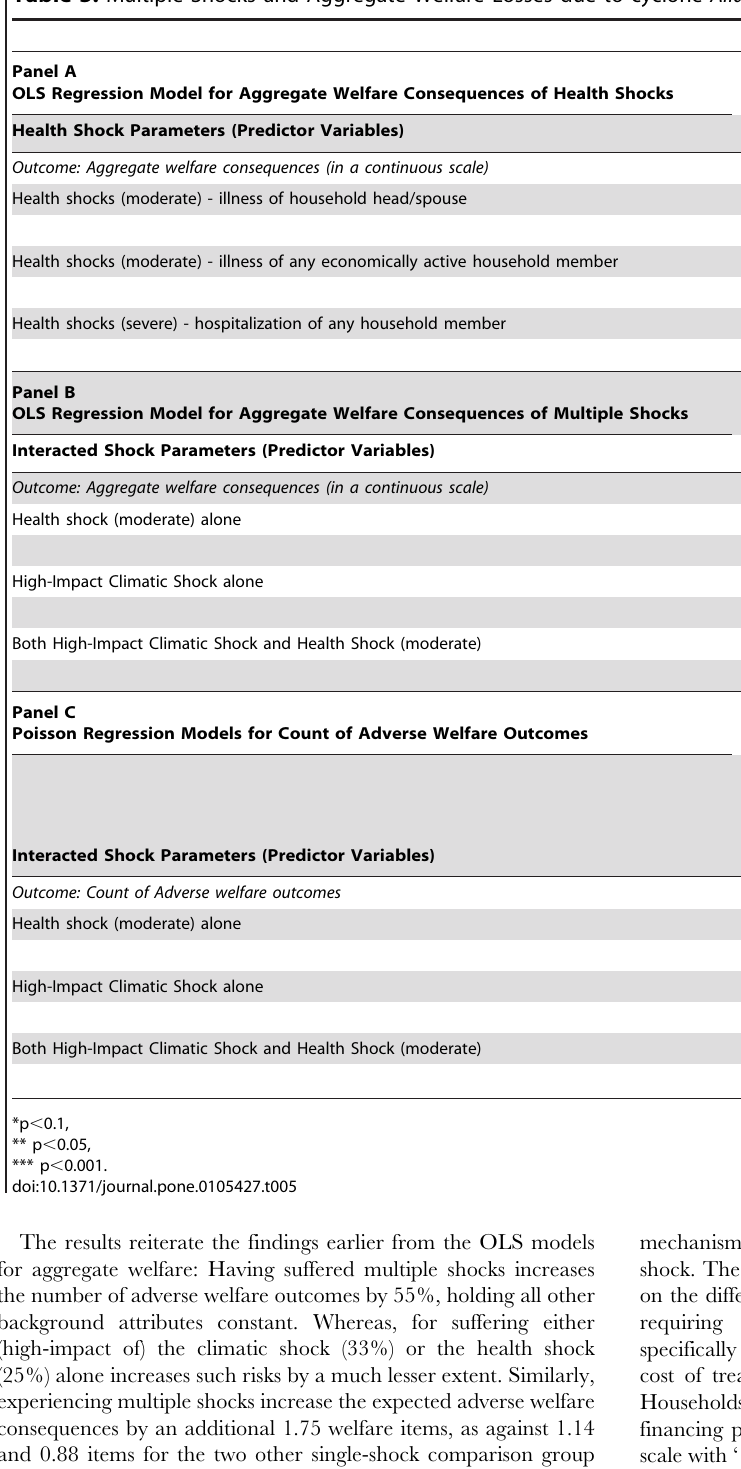
Table 5. Multiple Shocks and Aggregate Welfare Losses due to cyclone Aila , Sundarbans, West Bengal, India.